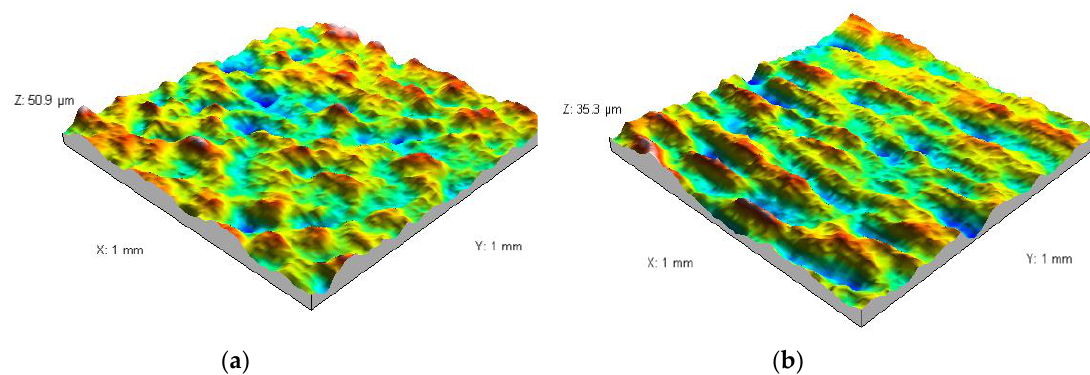
Figure 10. The surface of the reference material (PVC) ( a ) and material covered with biofilm ( b ).